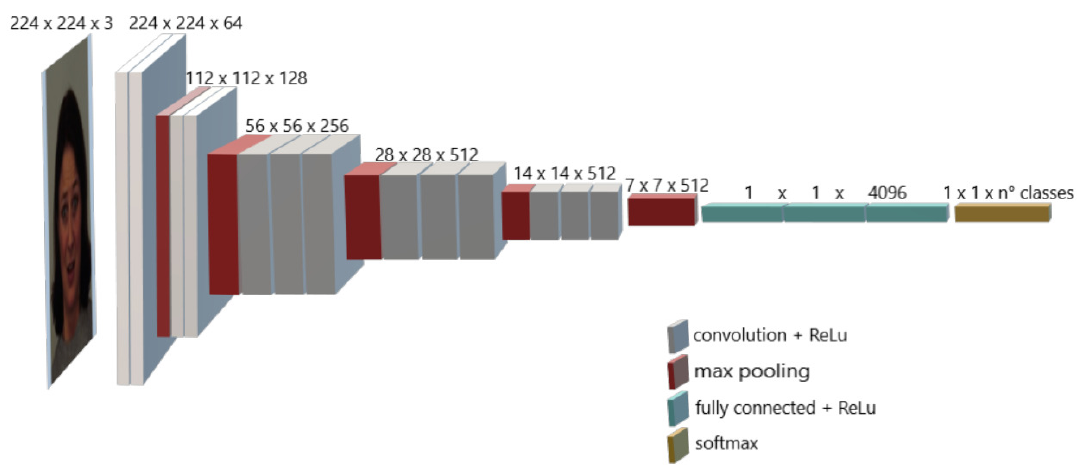
Figure 3. Architecture of the VGG16